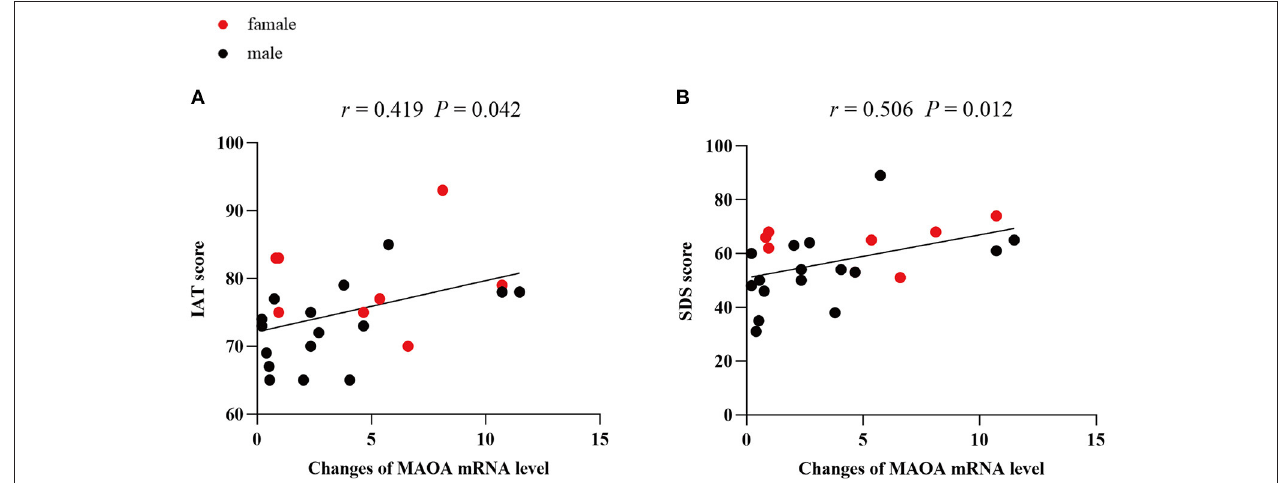
FIGURE 2 | Correlations between mRNA levels of MAOA and clinical scores in PIU. (A) Correlation between the mRNA level of MAOA and IAT score of patients with PIU, (B) Correlation between the mRNA level of MAOA and SDS score of patients with